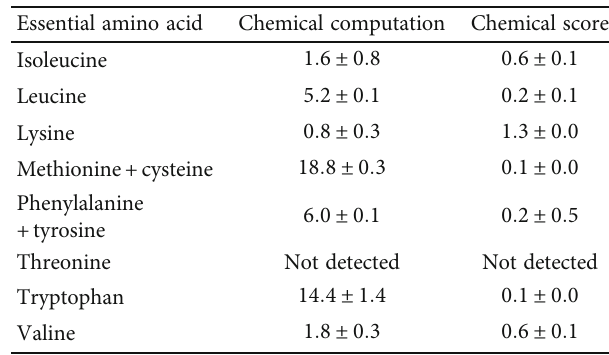
Table 2: Essential amino acid pro fi le of mesquite concentrate. Essential amino acid